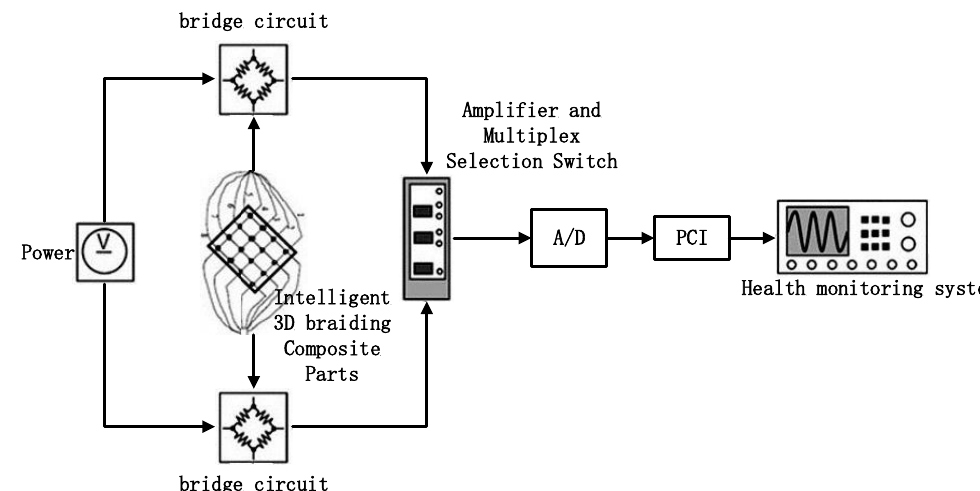
Figure 3. Damage detection system of the 3D braided composite.